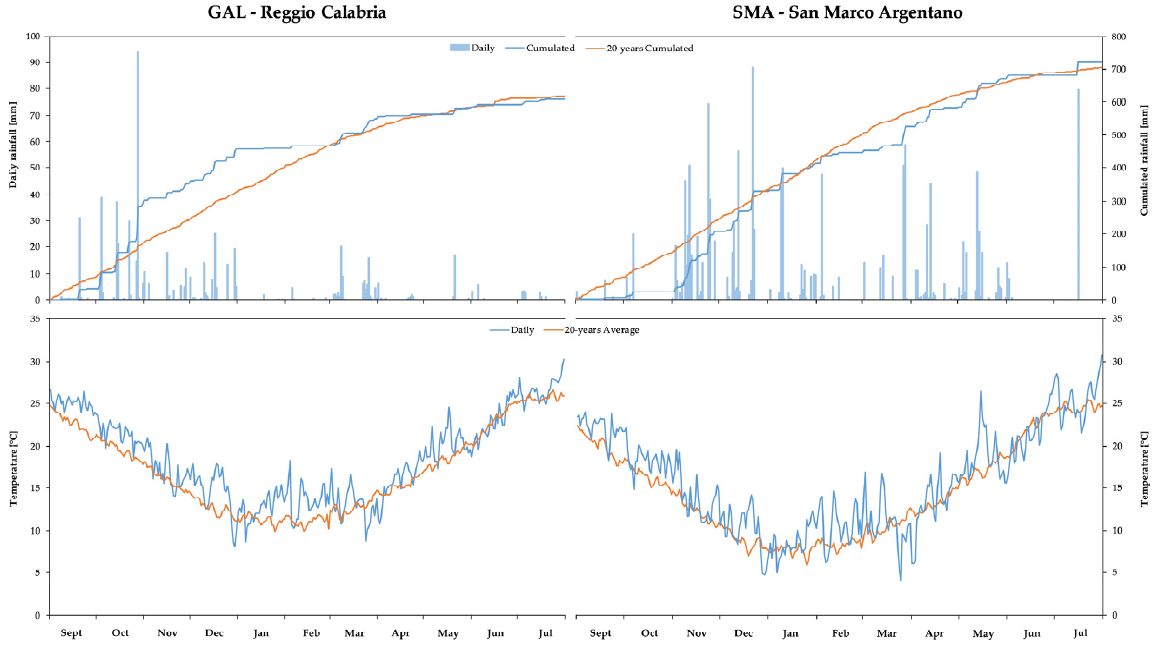
Figure 2. Daily and accumulated rainfall and daily mean air temperature at the experimental sites (GAL, on the left, and SMA, on the right) during the growing seasons (2019–2020); the graphs include a 20-yr average of accumulated rainfall and 20-yr average mean daily temperature trends. Biomass yield was affected by both soil and tillage but not by their interaction (Table 1). Table 1. Effect of soil (GAL and SMA), tillage system (CT and NT) and their interaction on wheat biomass and grain yields, harvest index (HI), test weight (TW), thousand kernels weight (TKW), straw and grain N (N-Straw and N-Grain) and P (P-Straw and P-Grain) concentrations. Reported values are means ( n = 4). Different letters indicate significant differences (Tukey’s HSD test at p < 0.05) between treatments (Soil × Tillage).